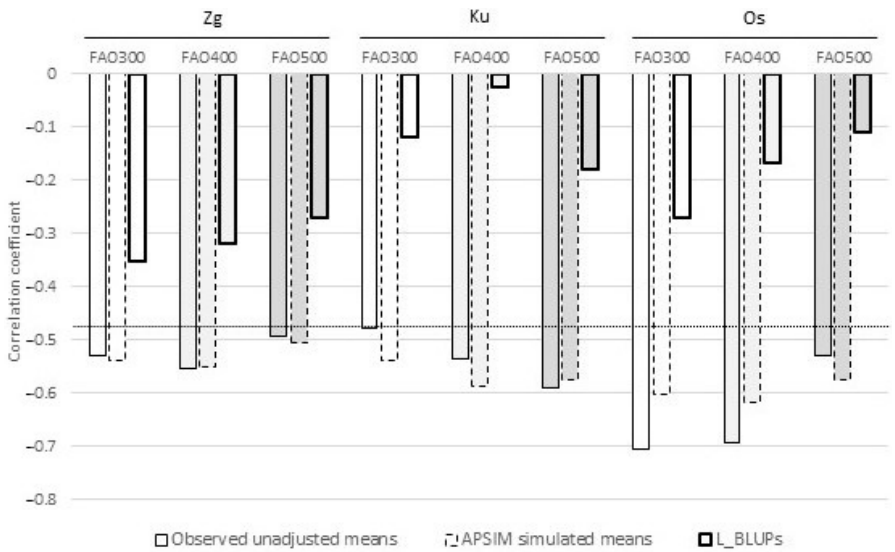
Figure 6. Correlation coefficients between grain yield estimated by observed unadjusted means, APSIM simulated means, L_BLUPs for maize genotypes of three maturity groups and SDD values across three geographically distinct locations in Croatia in the two-decade period. The dashed vertical line denotes significance level at p <